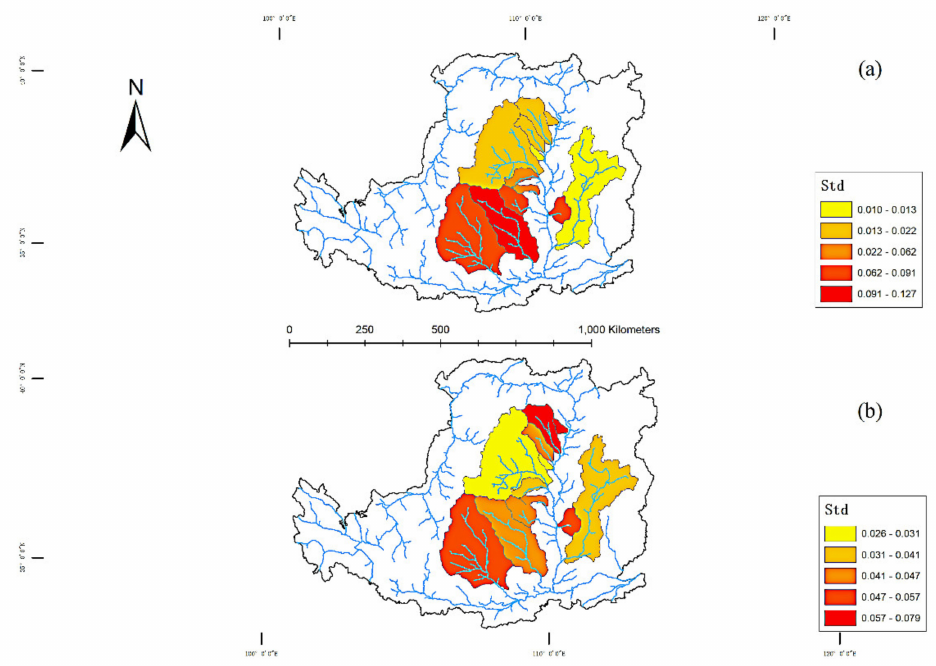
Figure 6. Map of the standard deviation (Std) of quantitative contributions calculated by ( a ) various methods with FAO E 0 estimation and ( b ) method Budyko with various E 0